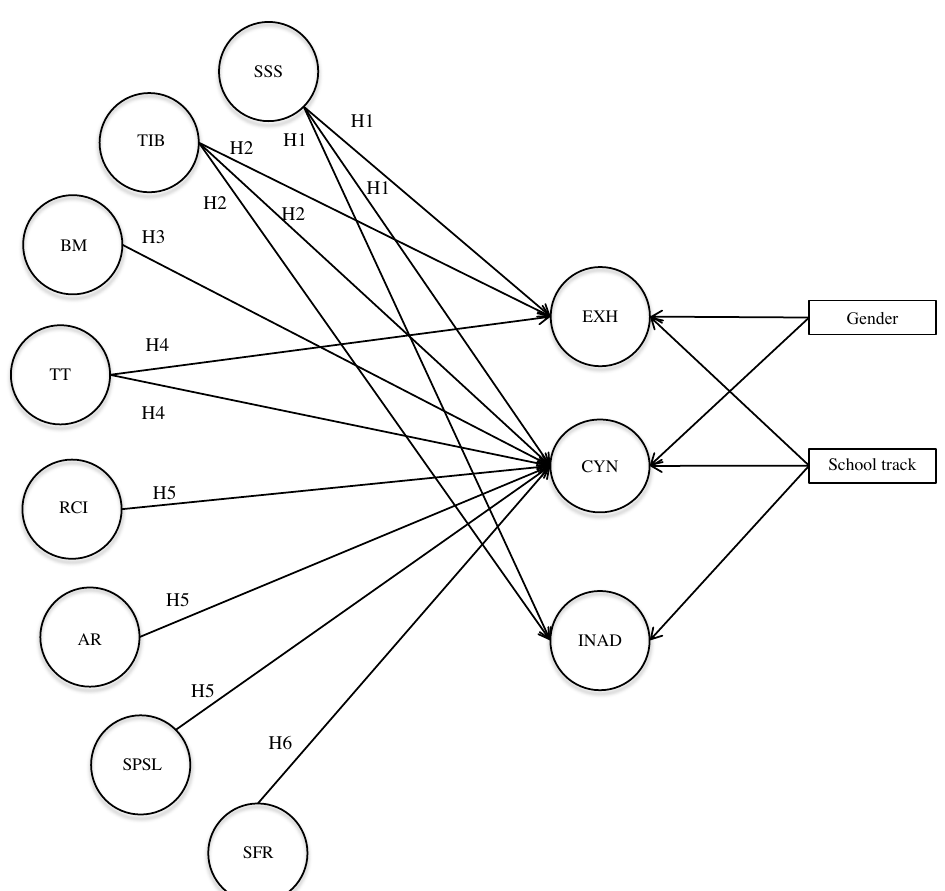
Figure 1. Hypothetical model (showing only latent variables). EXH = Exhaustion, CYN = Cynicism, INAD = Inadequacy; SSS = Support for Struggling Students, TIB = Teachers’ Instructional Behavior, TT = Teaching Time, RCI = Rule clarity and implementation, AR = Application of rules, SPSL = Students’ Participation in School Life, BM = behavioral management, SFR = School–family